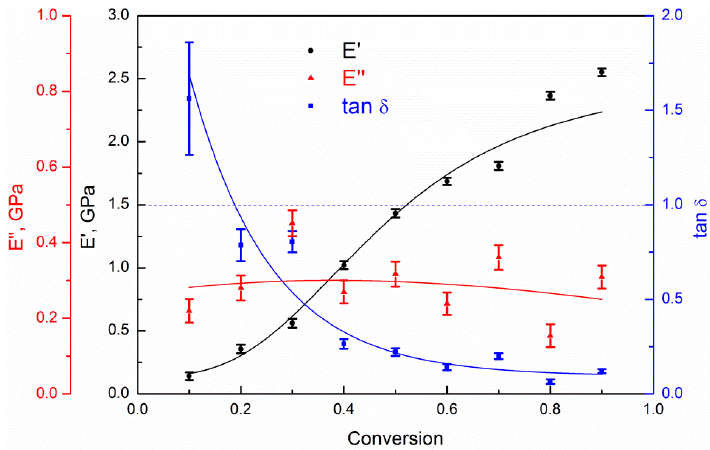
Figure 5. The dynamic mechanical moduli, E’, E”, and mechanical loss coefficient, tan δ , for systems at T = 450 K as a function of the conversion degree. The oscillation frequency varied in the range of 5.3 · 10 8 –5.4 · 10 8